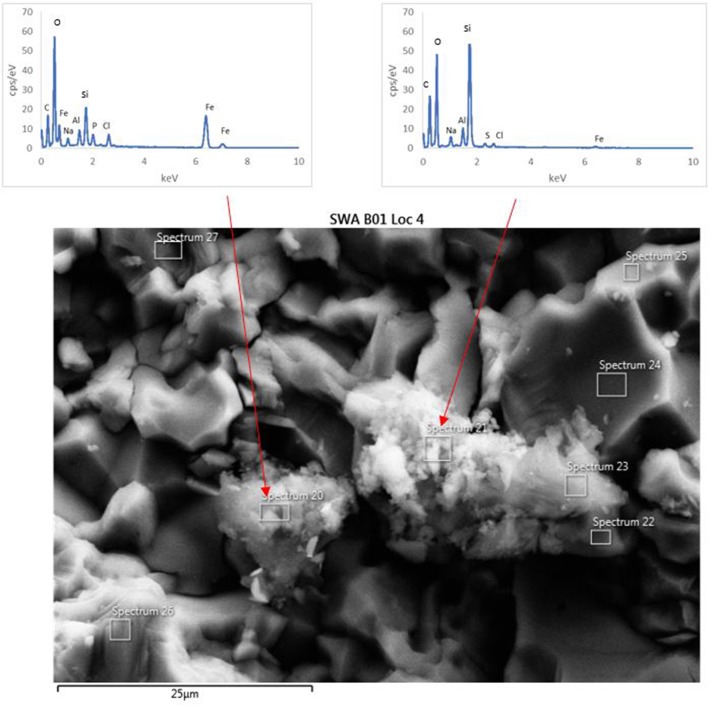
FEG-SEM micrograph of a typical secondary minerals produced in the biological flasks after 28 days. No secondary minerals were observed in the abiotic controls.